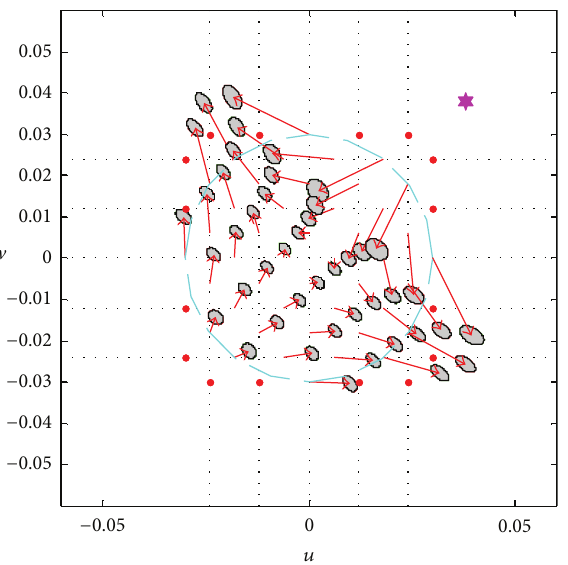
Figure 13: Bias and standard deviation ellipses for different target positions.